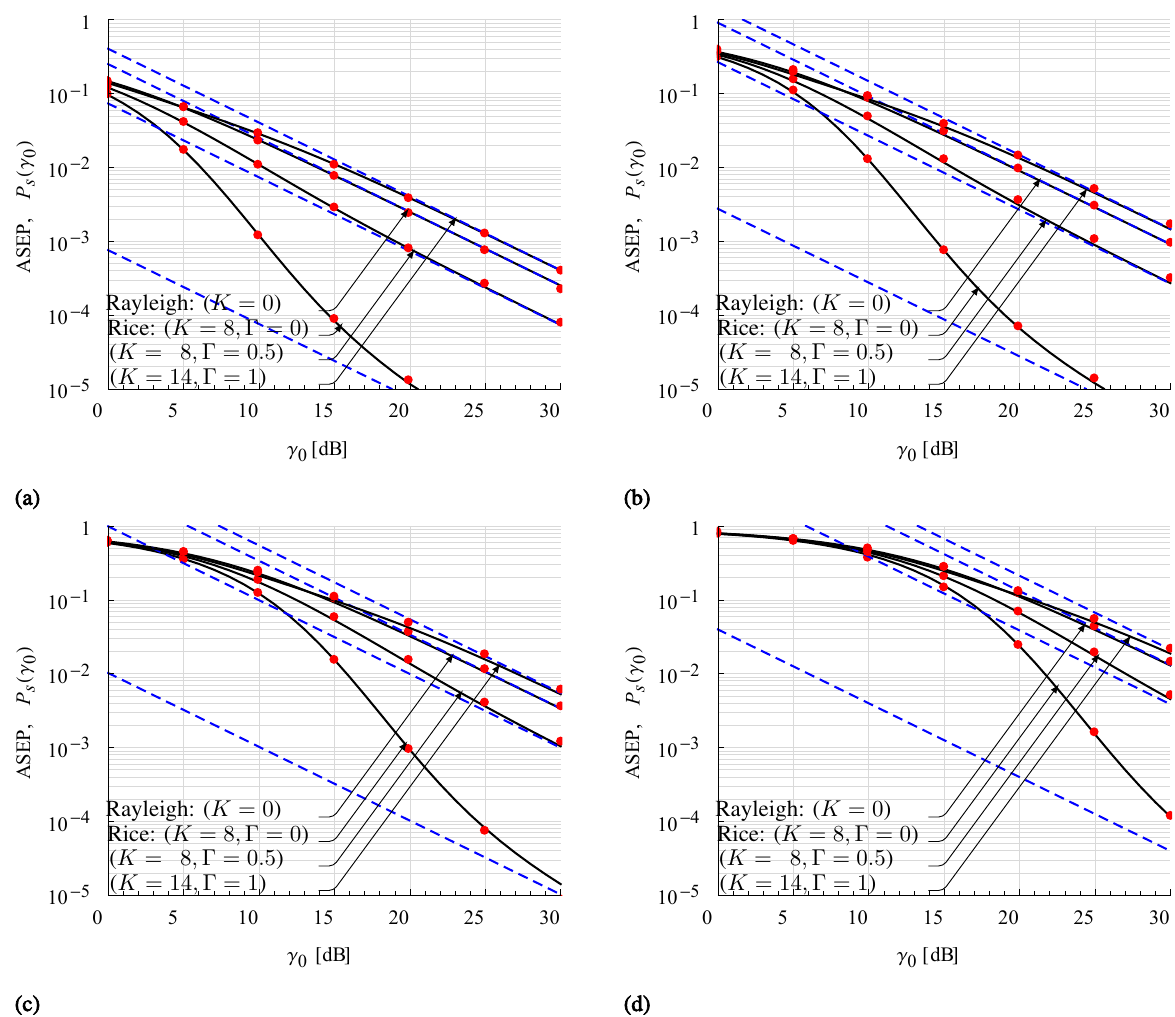
Figure 5. Exact (solid line) and asymptotic (dashed line) expressions of TWDP ASEP for ( a ) 2-PSK, ( b ) 4-PSK, ( c ) 8-PSK and ( d ) 16-PSK modulations compared with Monte Carlo simulation results